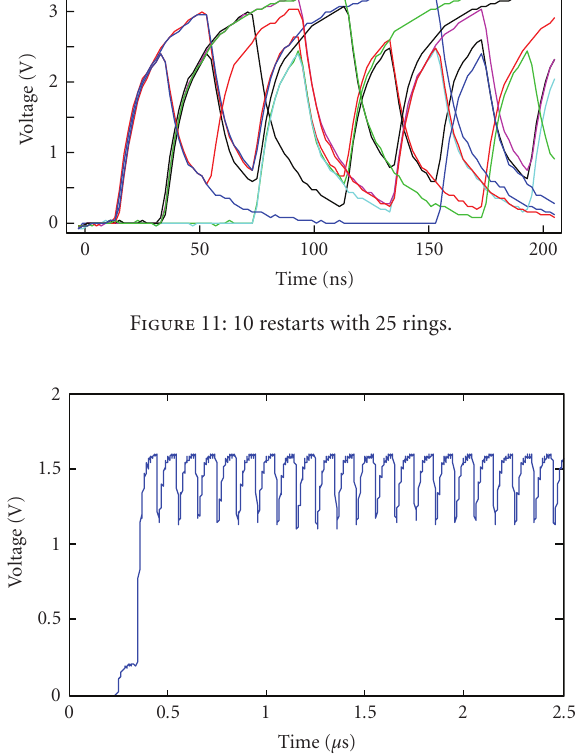
Figure 12: Standard deviation of 1000 traces, sampling frequency 10MHz and 25 rings.